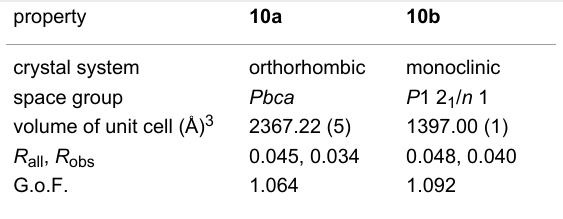
Table 4: Key crystallographic data for carbamates 10a and 10b , which are representative products of the Hofmann rearrangement of amides 9 (Scheme 2, Figure 2)